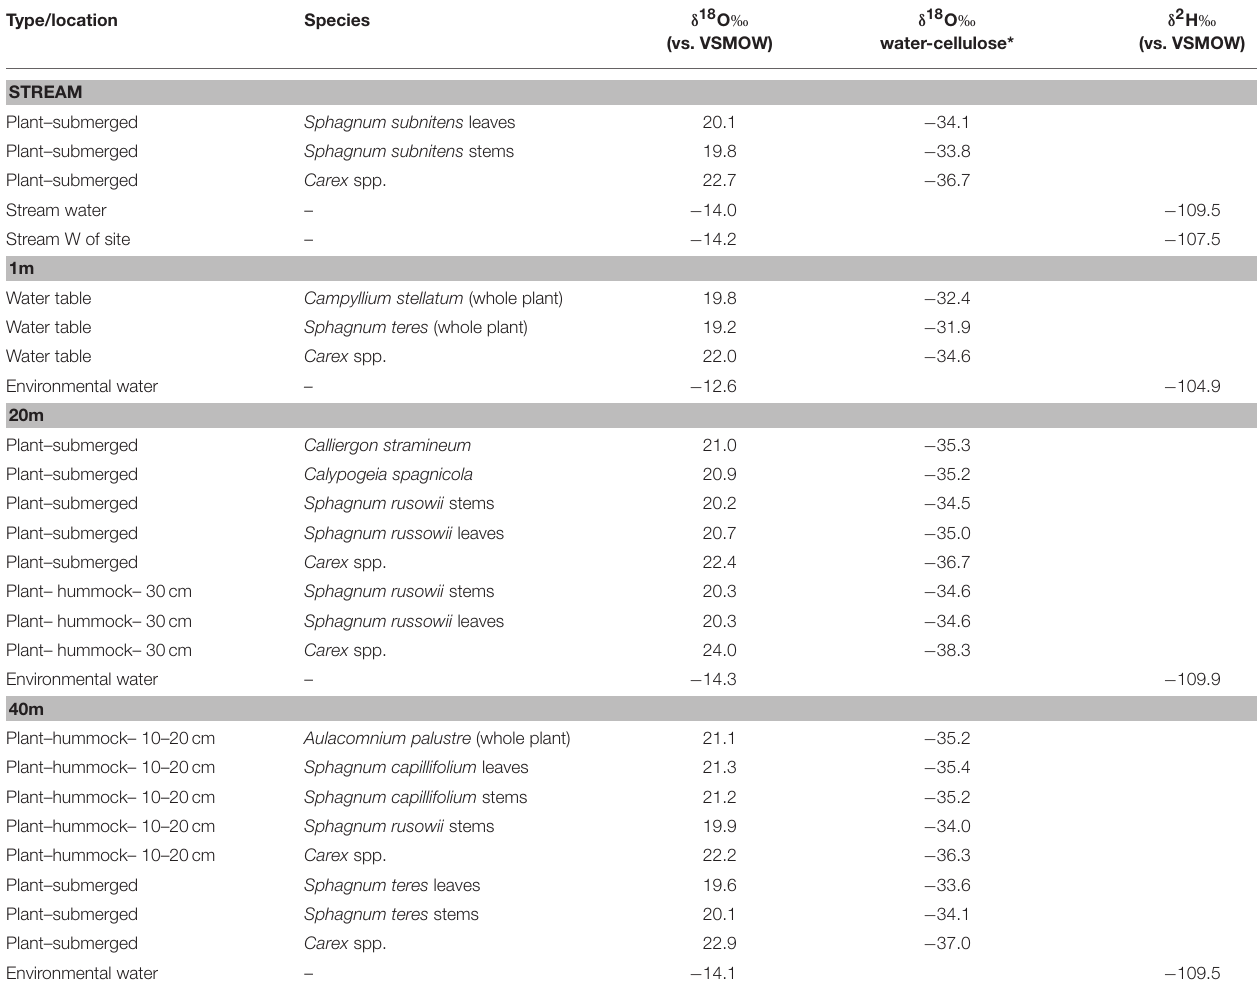
TABLE 2 | Goldfin (GF) plant cellulose and environmental water isotopes (sampled 9/1/2017). Type/location